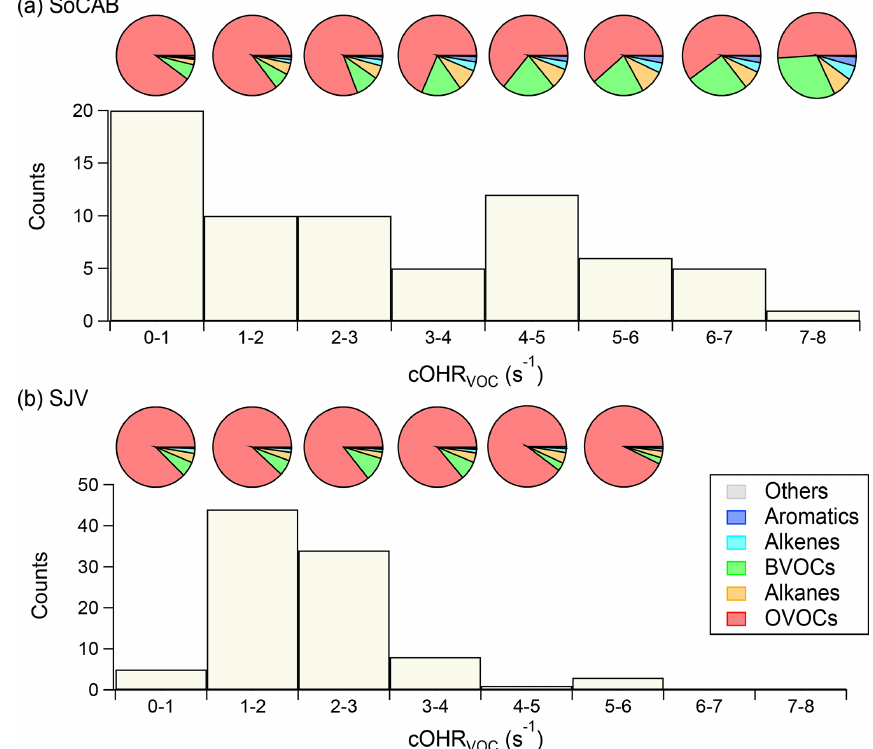
Figure 6. Frequency distribution of cOHR VOC in the (a) SoCAB and (b) SJV. Also shown above each 1s − 1 binned cOHR VOC range is a pie chart presenting the average contribution to the cOHR VOC by VOC categories (shown in the